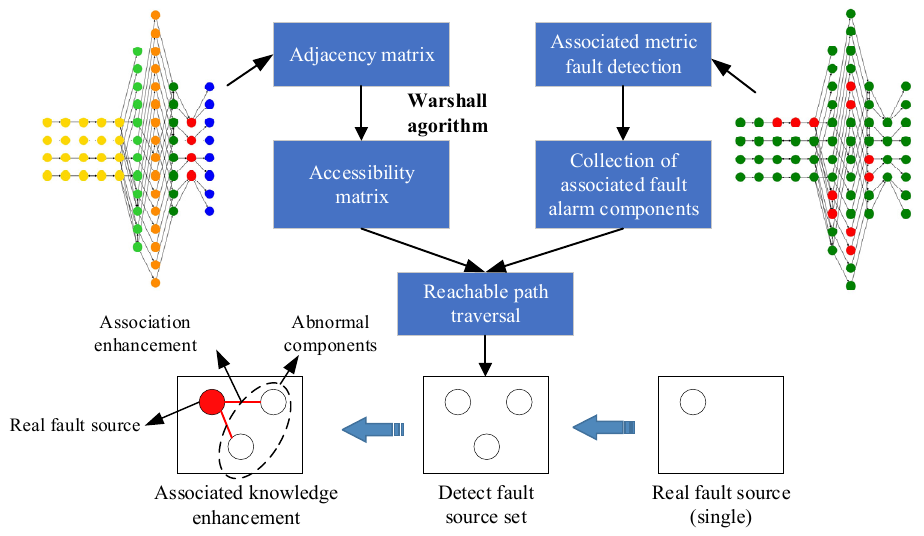
Figure 5. Knowledge enhancement process of power supply system association graph model.